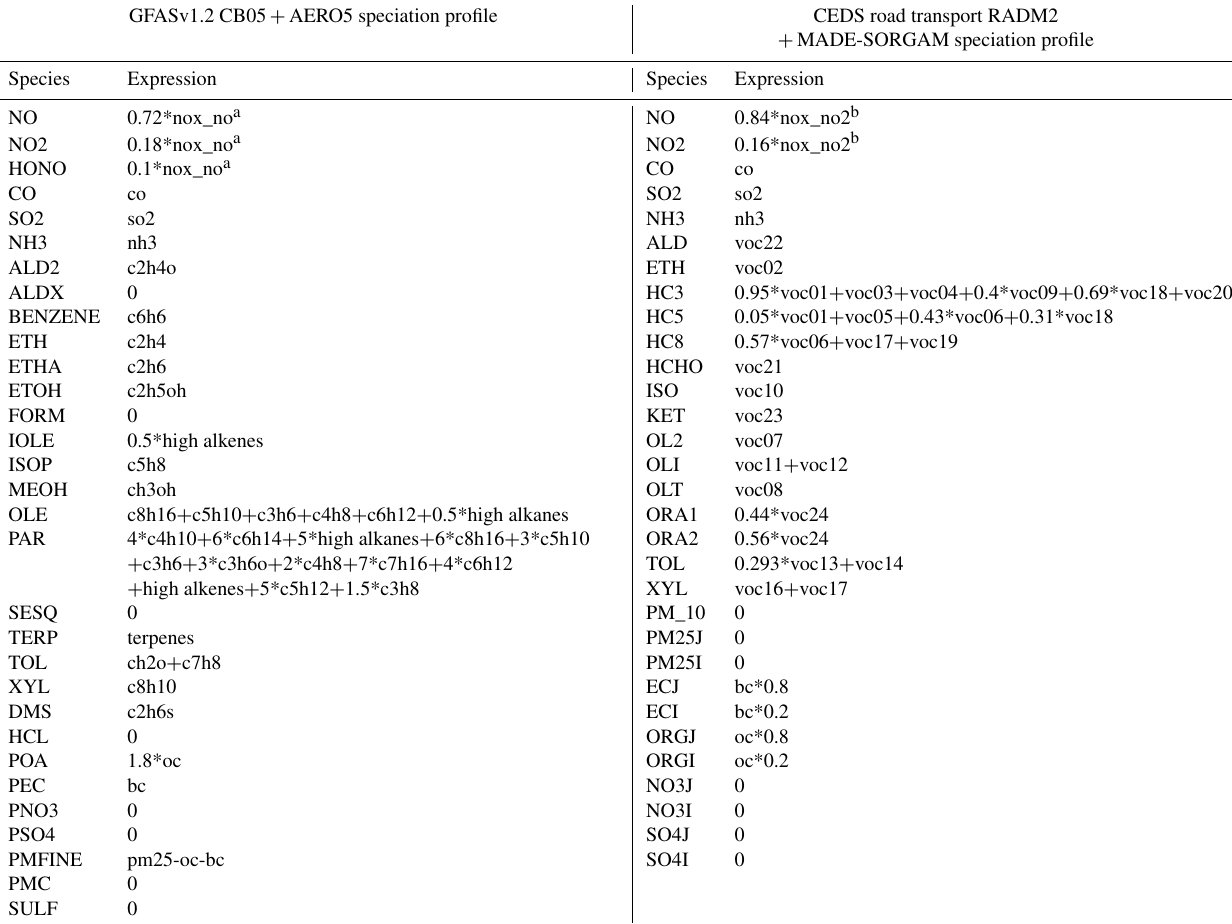
Table 2. Example of speciation profiles included in HERMESv3_GR for mapping the GFASv1.2 emissions to CB05 and AERO5 and the CEDS road transport emissions to RADM2 and MADE/SOGARM chemical mechanisms. Any species not mentioned in this table are defined in Table A2 in the